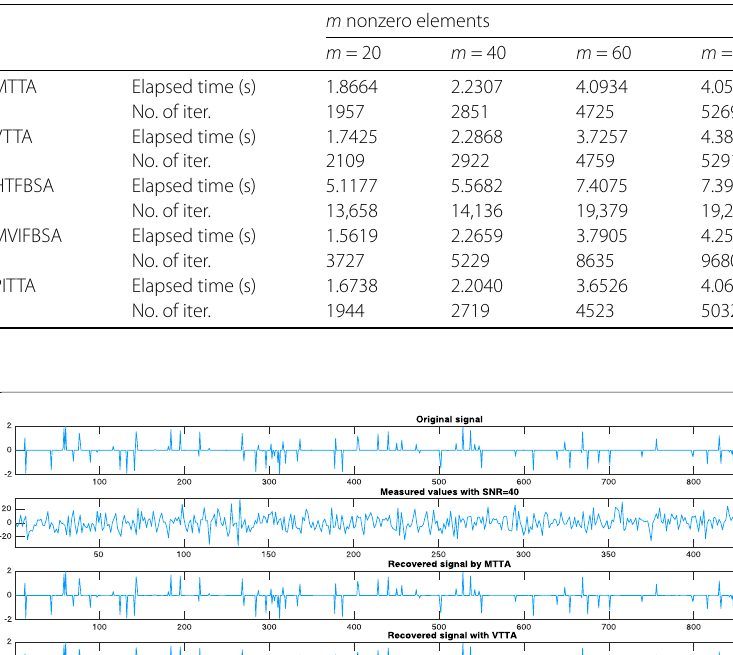
Table 7 Numerical comparison of five algorithms